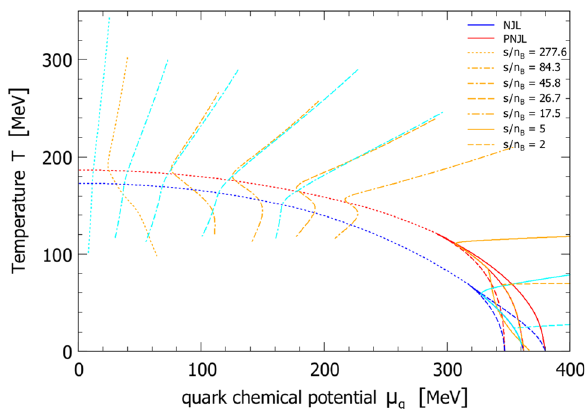
higher temperatures and lower chemical potentials. The red/blue curves are the transition lines with/without the coupling between the quarks and the Polyakov field